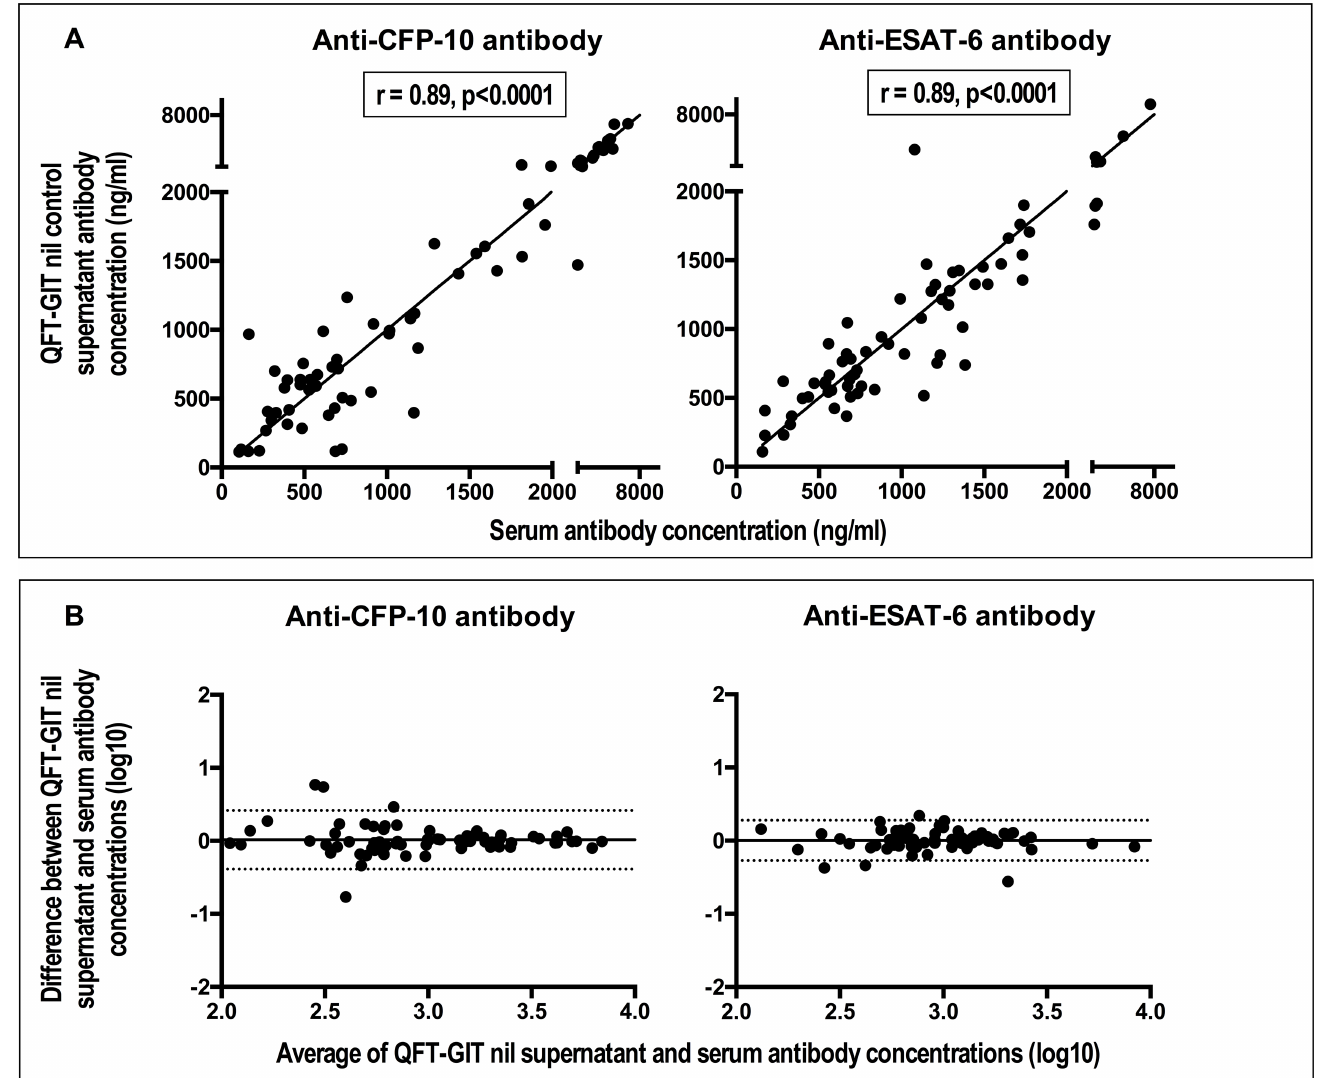
Fig 1. Anti-CFP (culture filtrate protein)-10 & anti-ESAT (early secretoryantigenic target)-6 antibody concentrations in QFT-GIT (QuantiFERON ® -TBGold in tube-test) nil control supernatants strongly correlate with those in paired sera and there are no statistical differences between them. Panel A: scatter plots showingcorrelation.The coefficient (r) and the p values shown correspond to results from Spearman’srank correlation.The solid lines are lines of identity. Panel B: Bland Altman plots showingagreement. The solid horizontalline represents the bias or averagedifference whilethe dotted horizontal lines are 95%